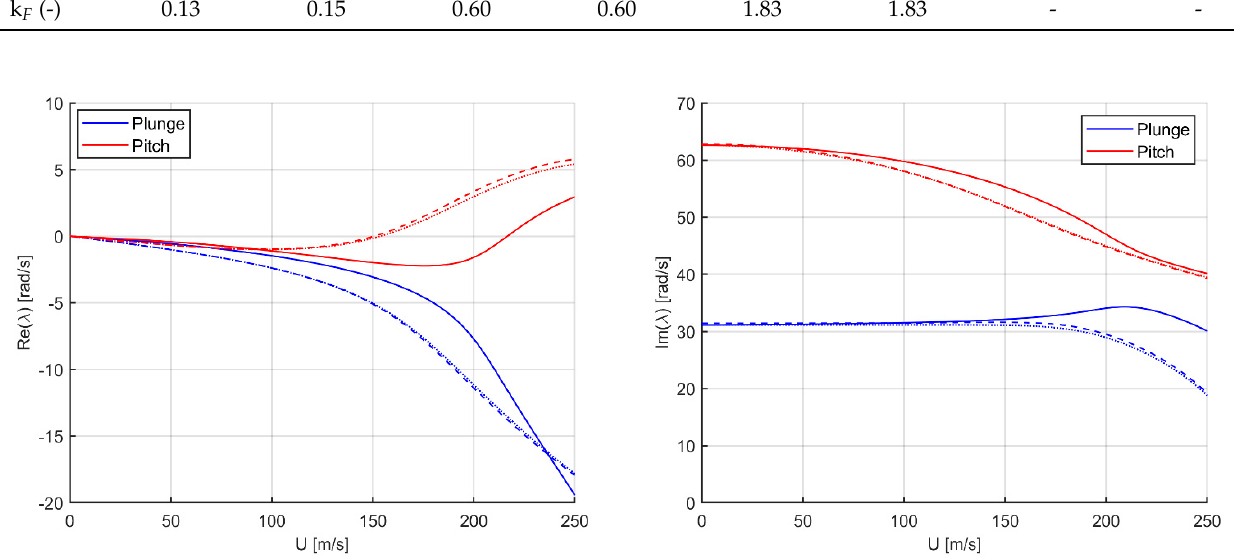
Appl. Mech. 2021 , 2 , FOR PEER REVIEW